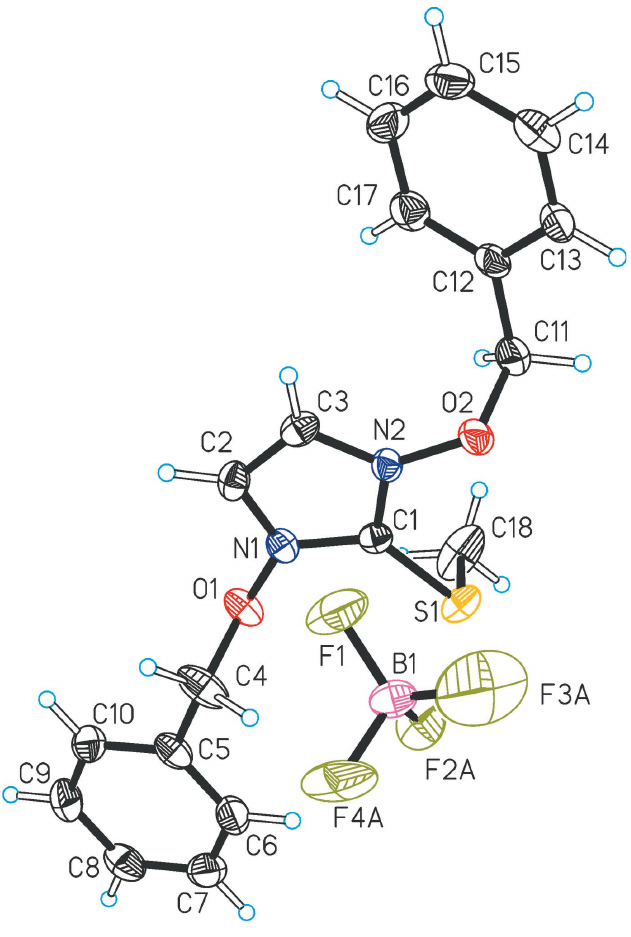
Figure 2 The ion pair structure of methylsulfanyl salt 2 , showing displacement ellipsoids drawn at the 50% probability level and hydrogen atoms drawn as spheres of arbitrary size. Only one of the three different orientations of the disordered BF 4 (cid:3) anion is shown.